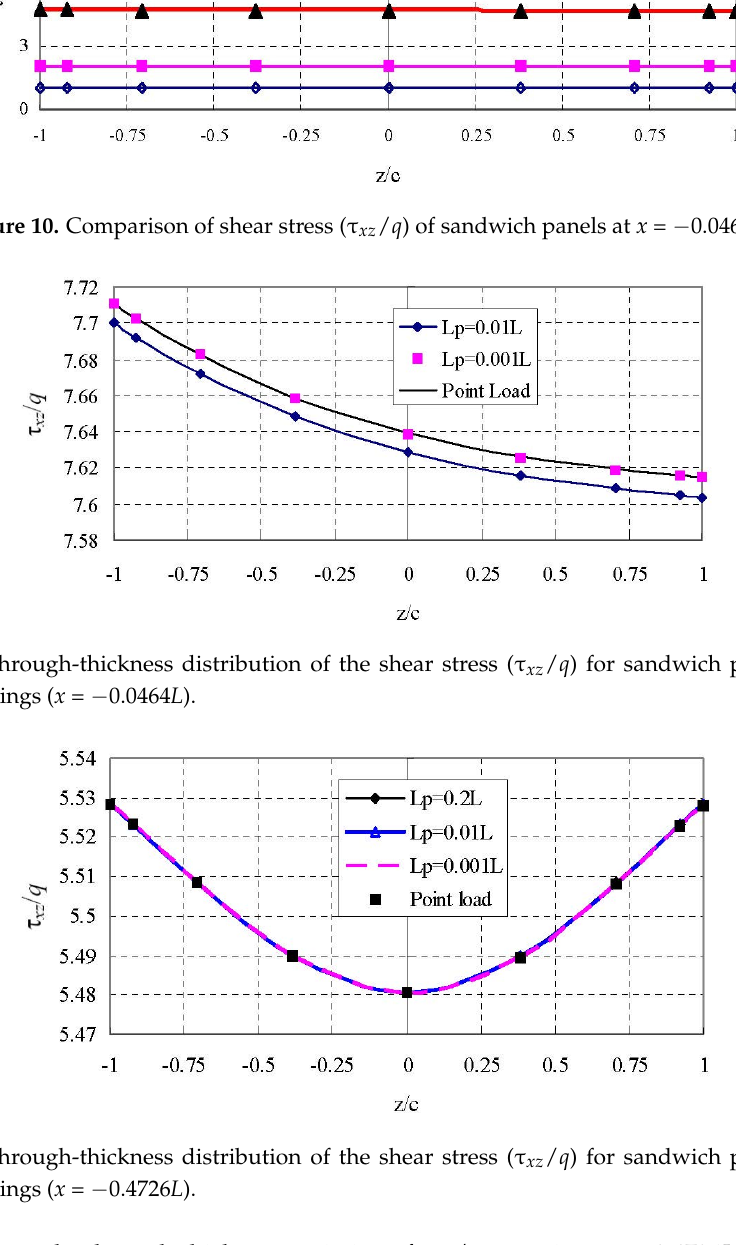
different loadings ( x = − 0.4726 L ).